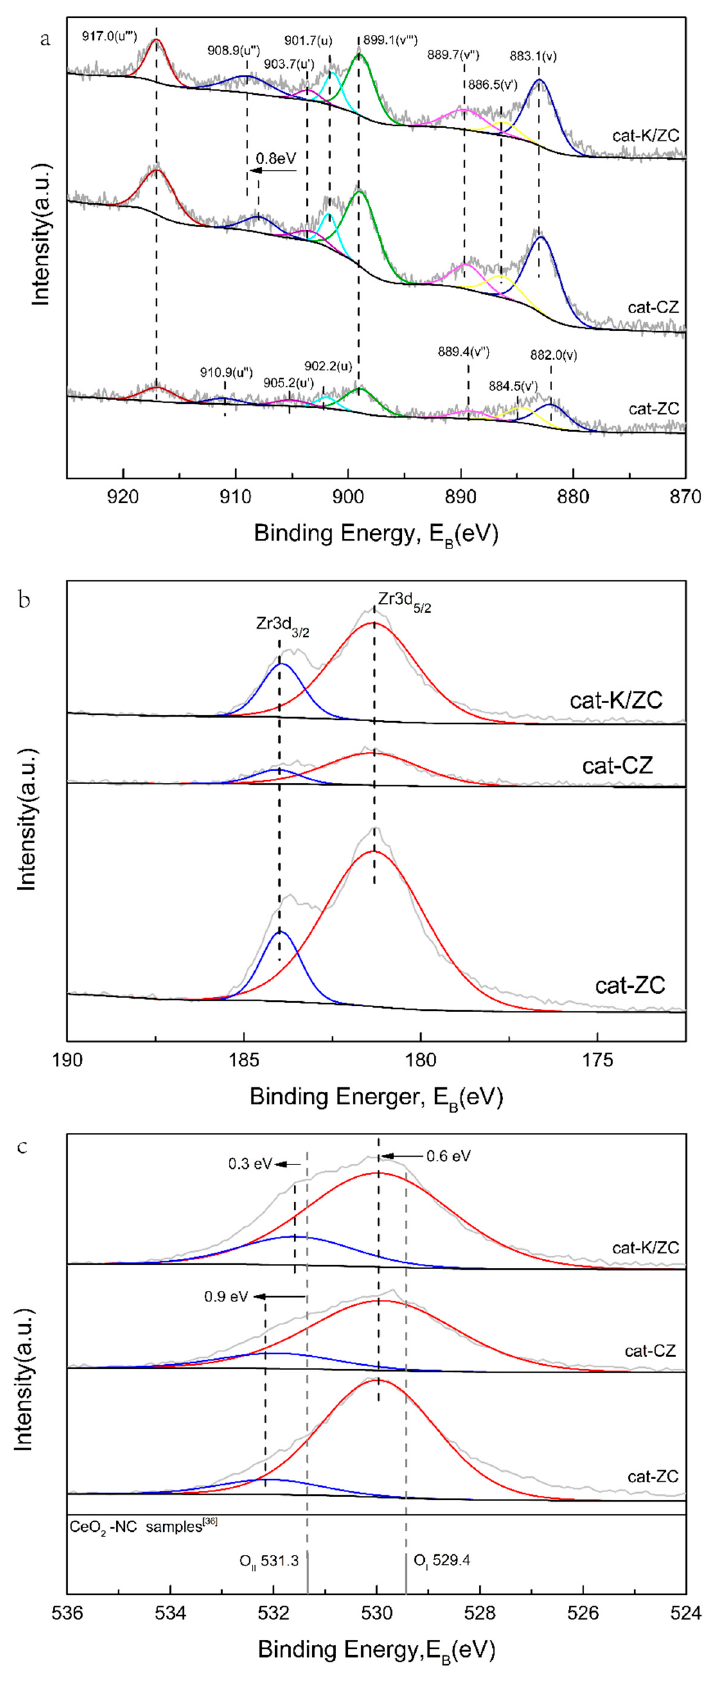
Figure 5. XPS spectra analysis of catalyst K/ZC, ZC and CZ, where ( a ) Ce 3d, ( b ) Zr 3d and ( c ) O 1s.